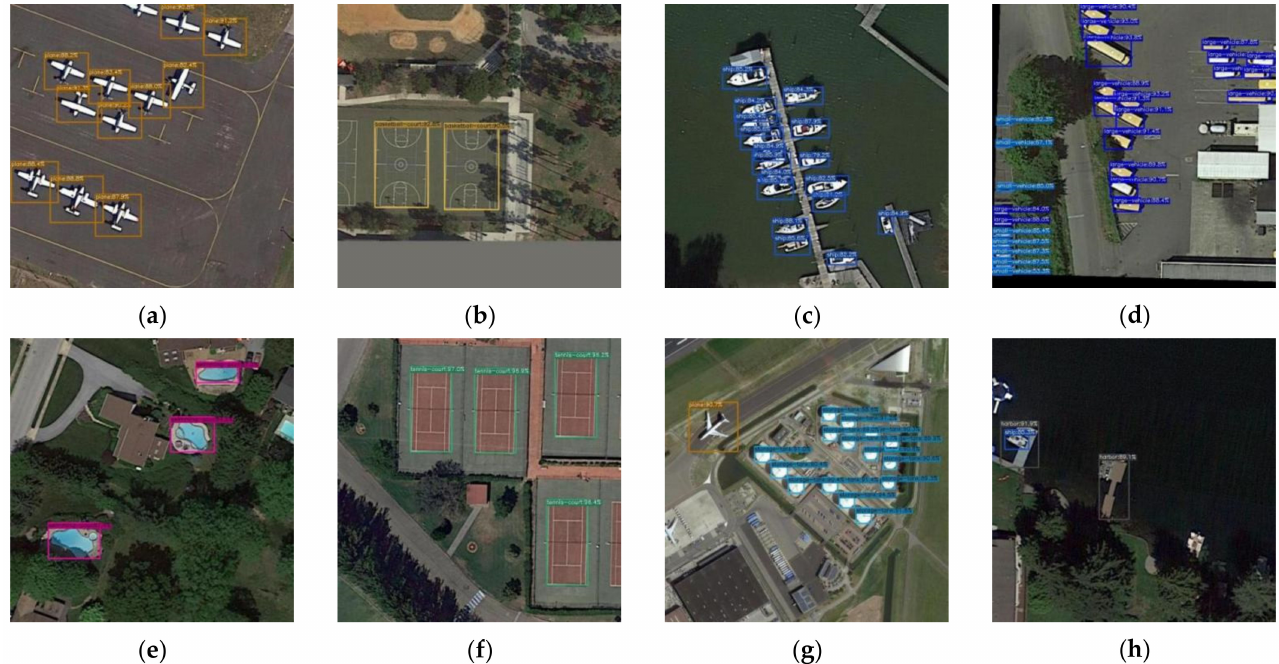
Figure 8. Detection results of small images on DOTA-v1.5 after the images were cut. ( a ) Plane, ( b ) basketball court, ( c ) ship, ( d ) large vehicle, ( e ) swimming pool, ( f ) tennis court, ( g ) storage tank, and ( h )